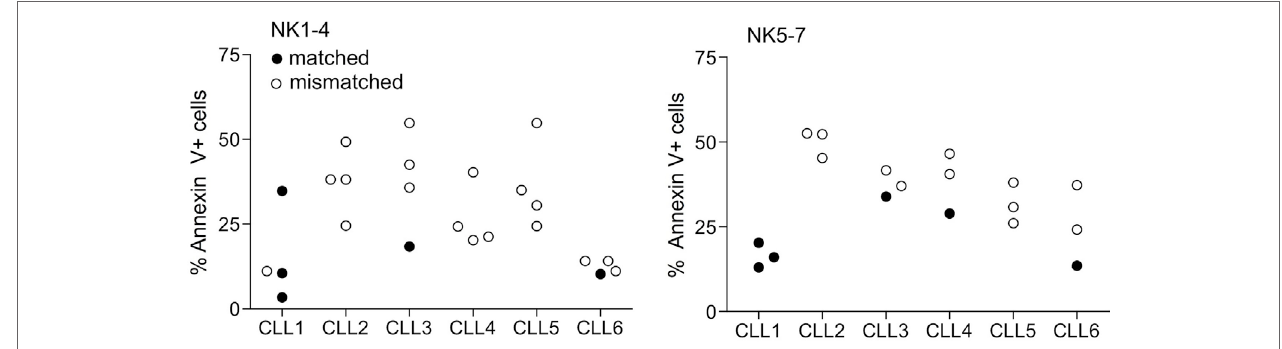
FigUre 4 | correlation between matched B-cll/nK cell combinations and cell death . The data in Figure 2 were now represented as matched and mismatched combinations. The graph represents the % of annexin V + cells in the 42 combinations (six B-CLL × seven NK) as described in legend to Figure 2 separated in two independent experiments (NK1-4 and NK5-7). White and solid symbols correspond to mismatched and matched combinations, respectively. Statistical analyses and results are described in Tables 4 and 5 .